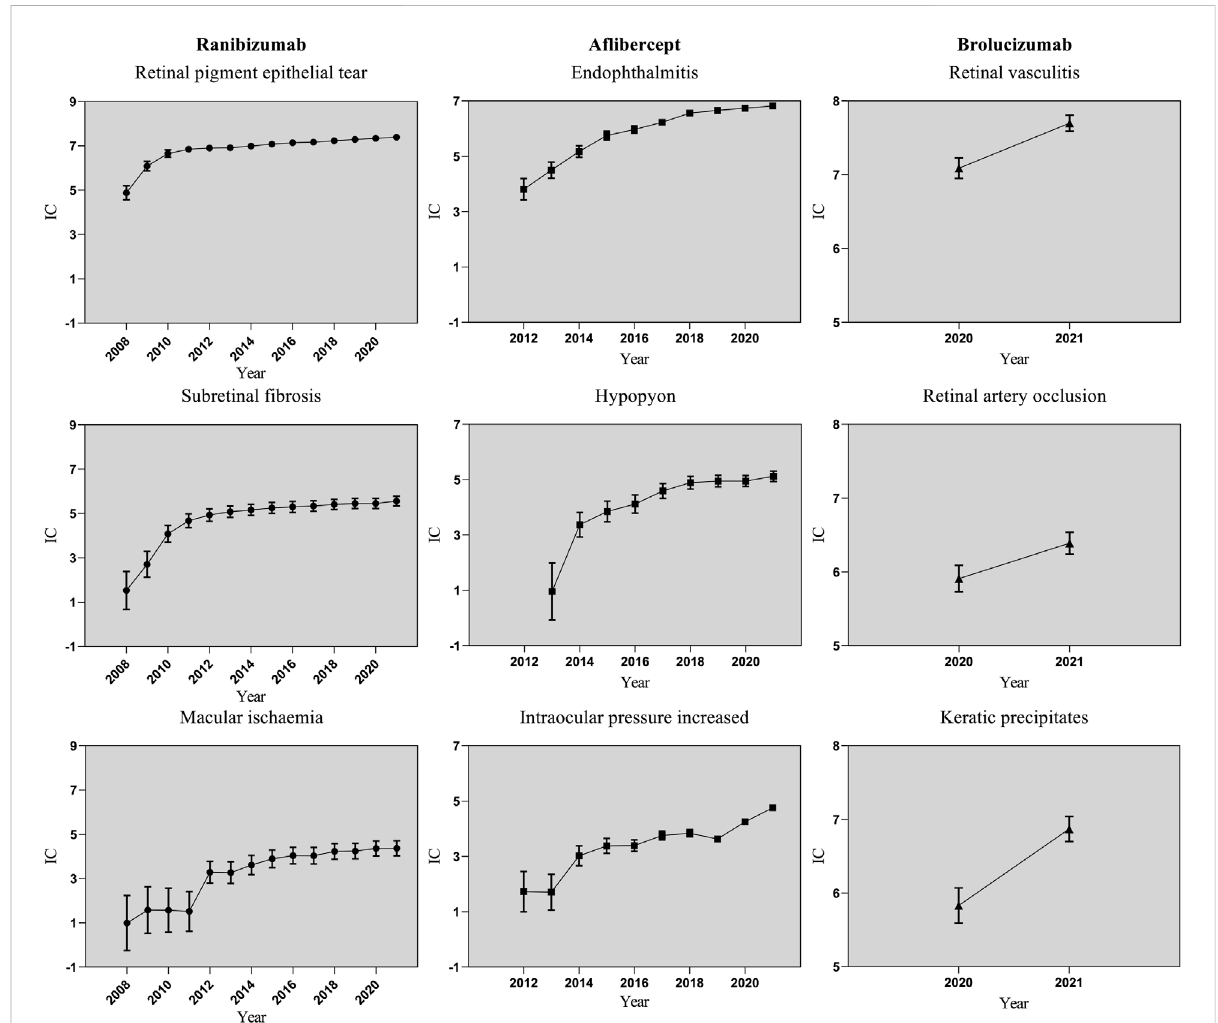
FIGURE 2 Information component and its 95% credibility interval over time for different types of anti-VEGF-associated ocular adverse events. Abbreviations: C , Ranibizumab; ■ , A fl ibercept; ▲ , Brolucizumab; IC, information component; CI, credibility interval. The error bars show the 95% credibility interval(CI)oftheinformationcomponent(IC),whentheIC curveissteadyupwardtrendandthe95%CInarrowed, thesignalisstable and strong